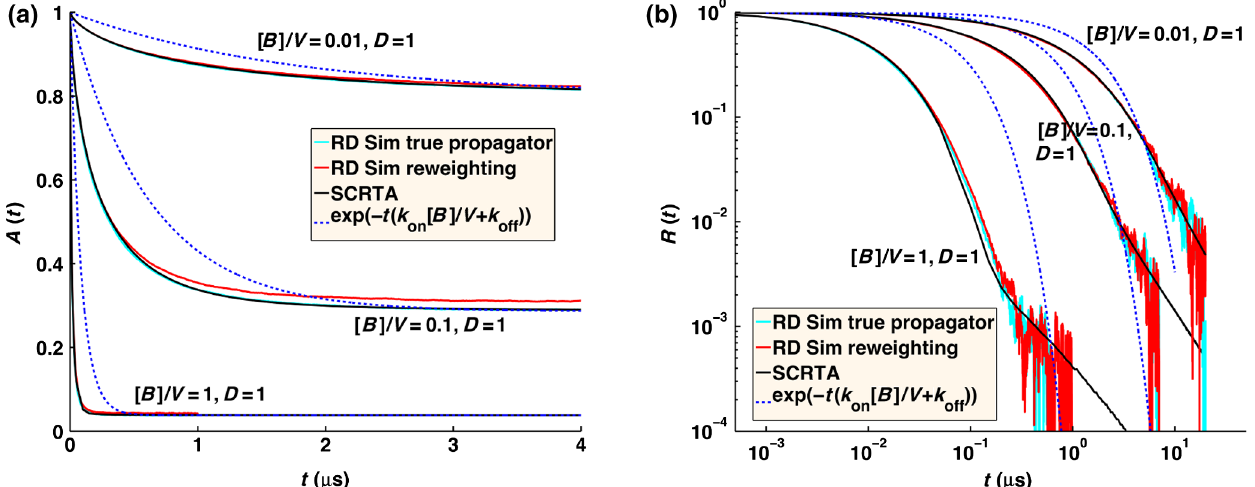
1 = ð 1 þ K B =V Þ . RD 0 eq ¼ eq